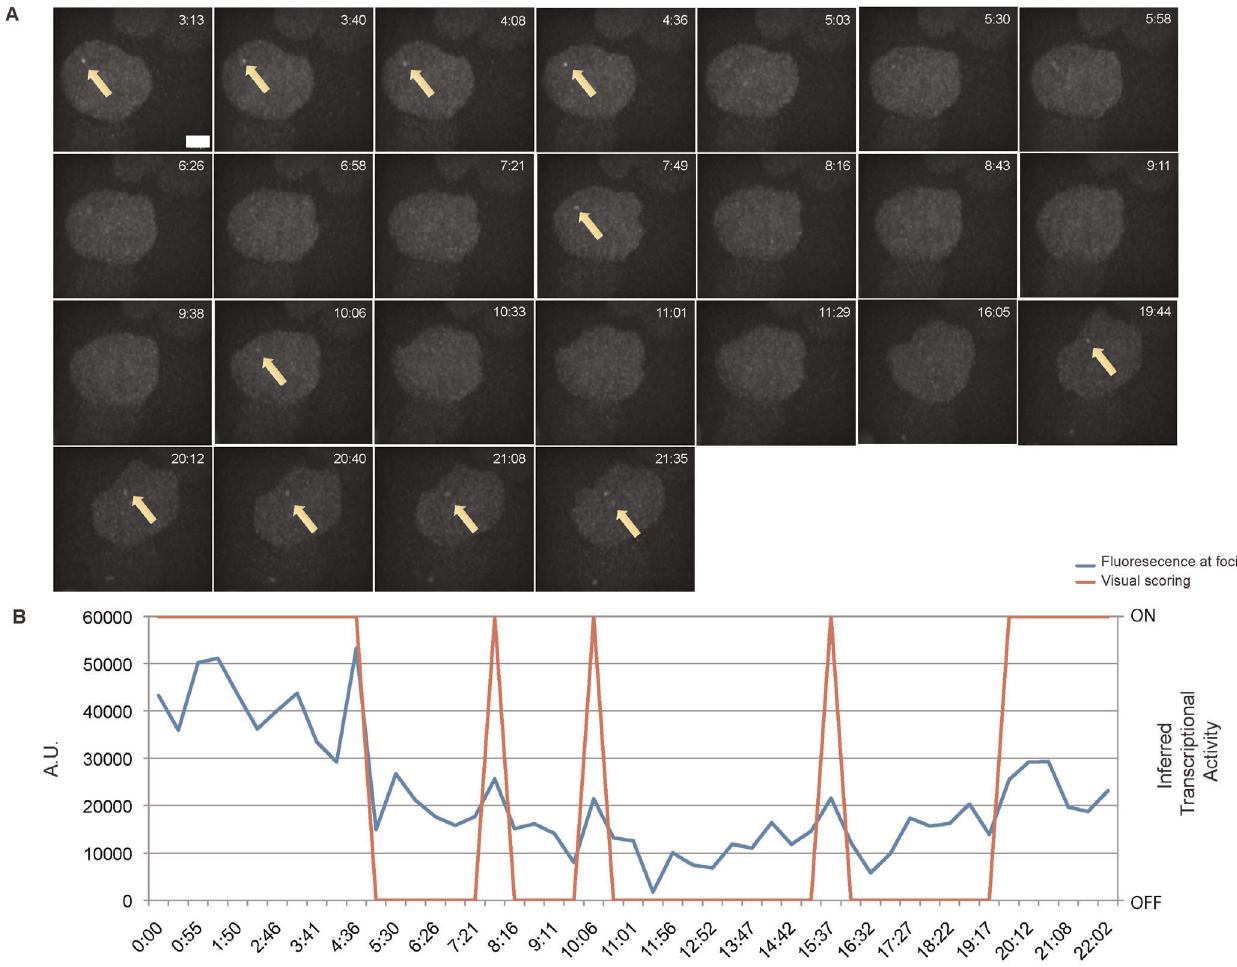
Figure 5. Detection of rapid transcriptional pulsing in Clone B6. A. Rapid and long transcriptional pulses (arrow) detected in a representative cell of Clone B6. Image acquisition was performed every 27 seconds. Scale bar=2.5 m M. B. Intensity time series data (blue line) of the pulsing cell depicted in Figure 5A. Red line represents inferred transcriptional activity by visual scoring.